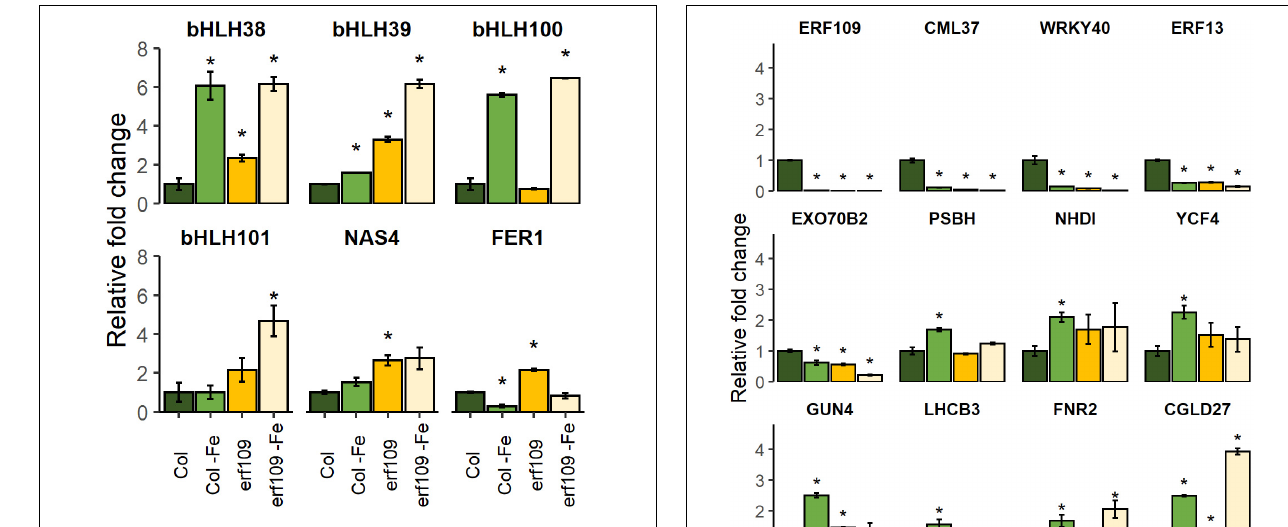
FIGURE 6 | Quantitative RT-PCR analysis of relative fold change of Fe-responsive genes in Col-0 and erf109 plants under Fe-sufficient or Fe-deficient conditions. The level of transcript was normalized to Col-0 under Fe-sufficient conditions. Data are presented as mean ± SE from two biological replicates. Student’s t -test significantly different at P < 0.05 is marked with an asterisk.